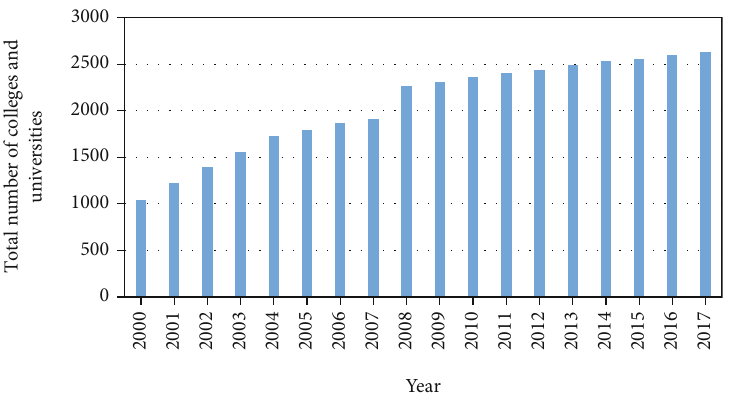
Figure 1: Increase of Chinese colleges and universities.